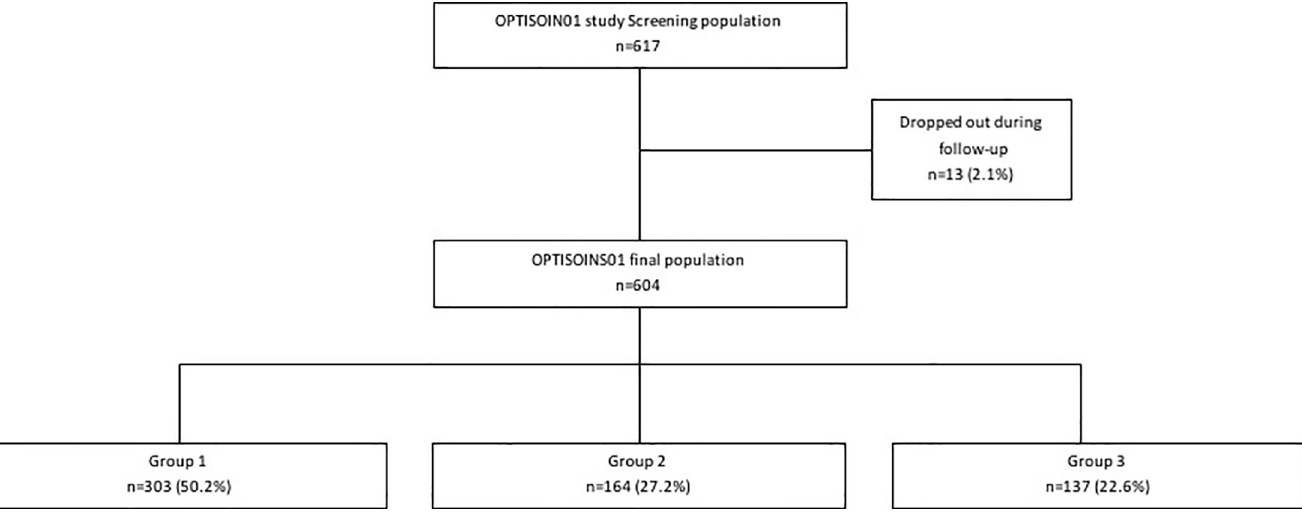
Fig 1. Flow chart of the OPTISOINS01